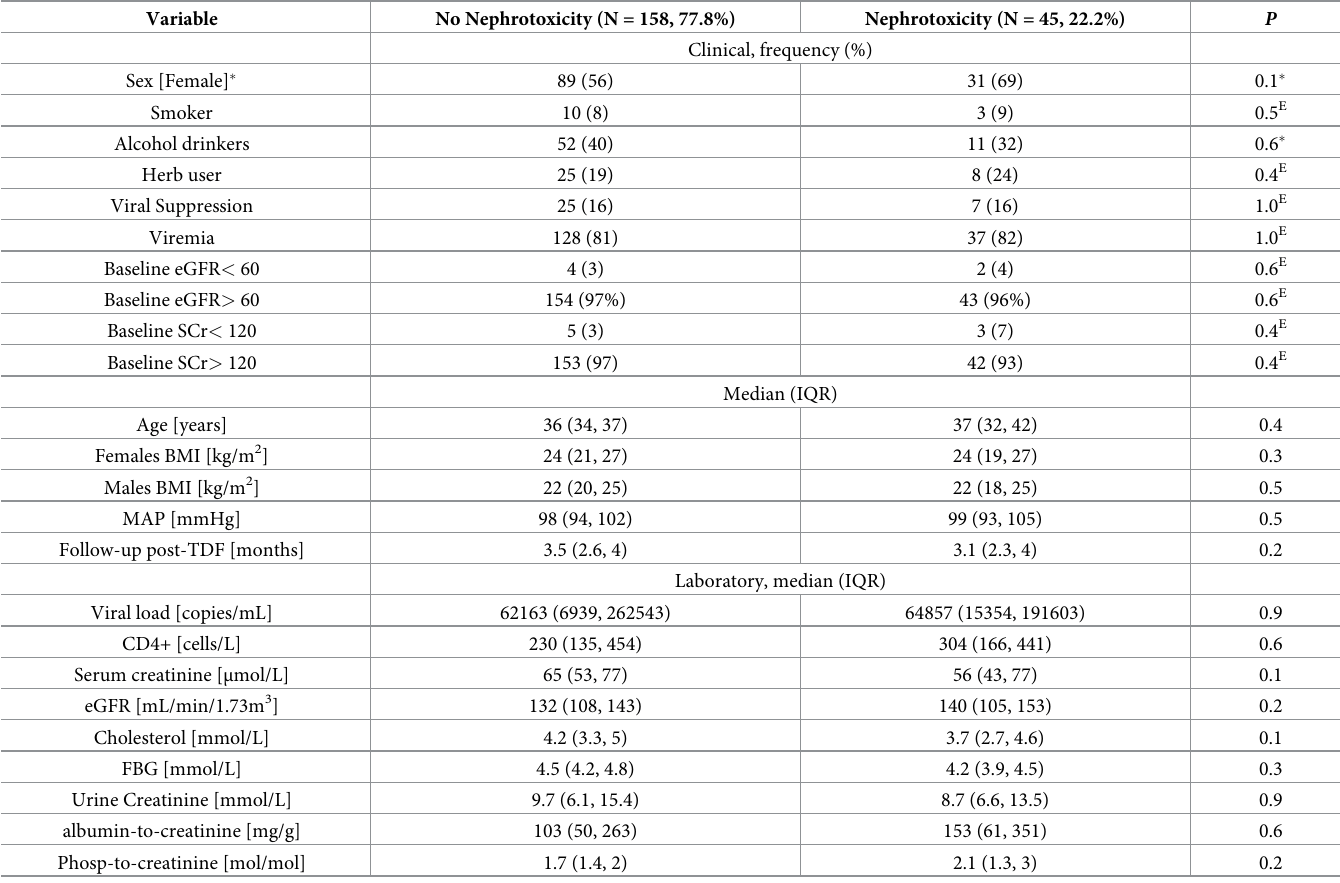
Table 1. Comparison of baseline clinical and laboratory characteristics stratified by TDF-associated nephrotoxicity.